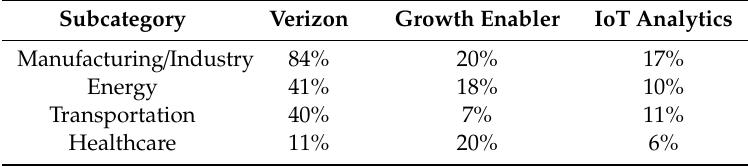
Table 14. Projections of IoT in smart city subcategories by 2025.